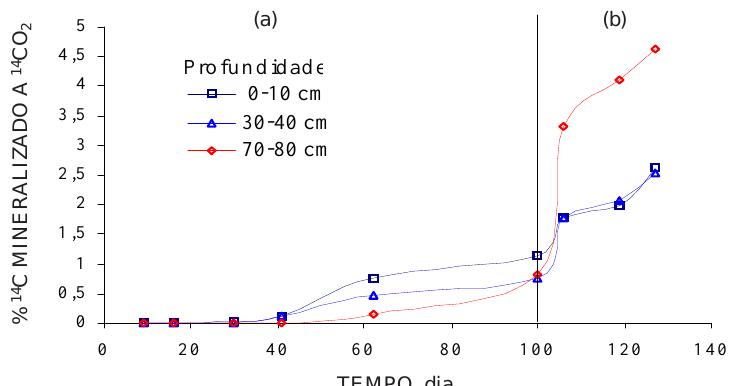
TEMPO, Figura 2. Mineralização de atrazina em amostras de Latossolo Roxo sob sistema plantio direto. (a) período de incubação sem adição de amido e (b) período com adição de amido.